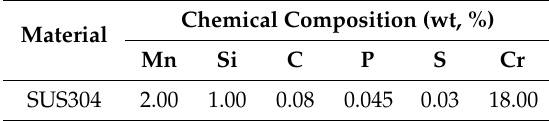
Table 4. Chemical composition of type 304 stainless